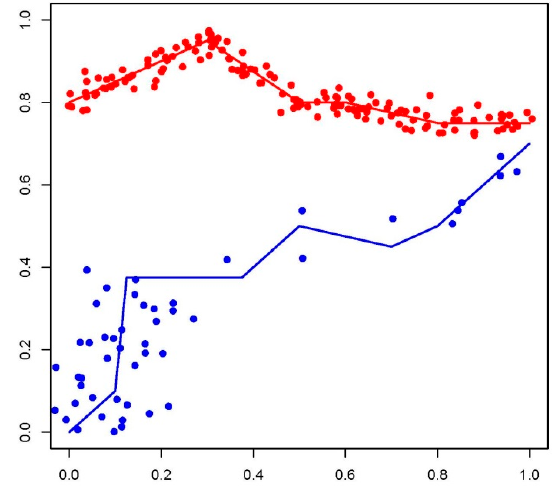
Figure 4. Realization of 150 HFC considered as base case (H 0 ). Simulated events associated with the road (river) appear in red (blue).